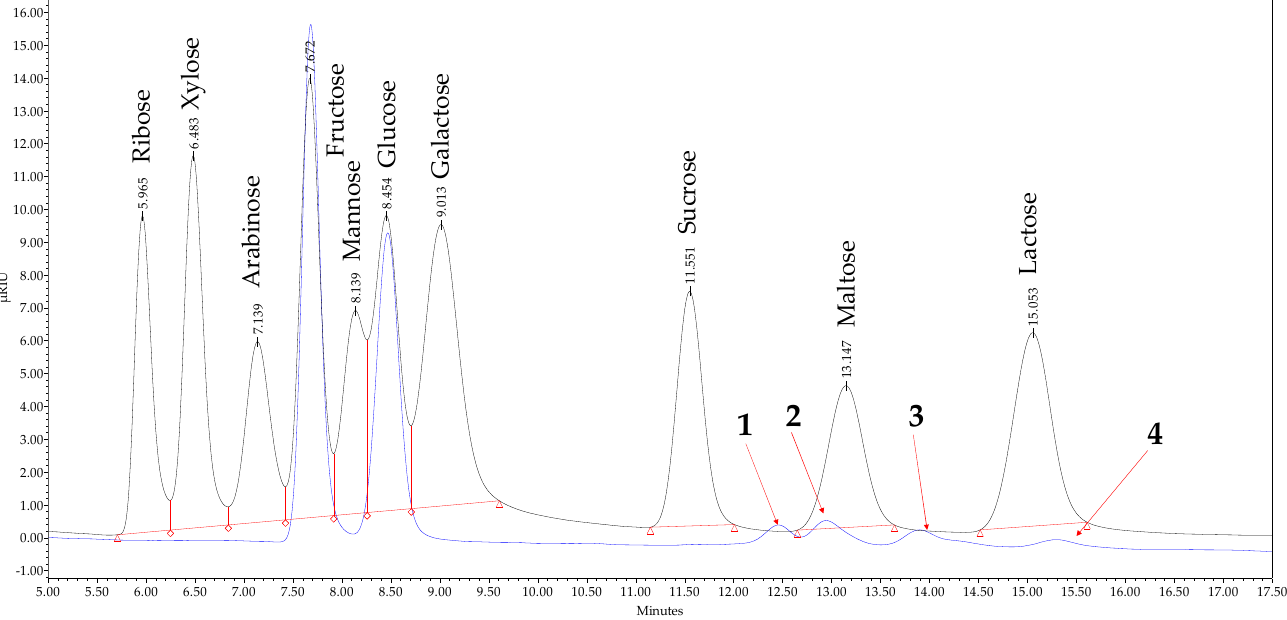
Figure 3. Representative chromatographic separation of mono- and disaccharide standards (black line) and sugars detected in honey samples (blue line). Samples injection volume 15.0 uL (0.075 ug mL −1 ). Peaks 1, 2, 3, and 4 refer to not identified compounds detected in honey samples with the retention time 12.447, 12.935, 13.884, and 15.286 min, respectively.